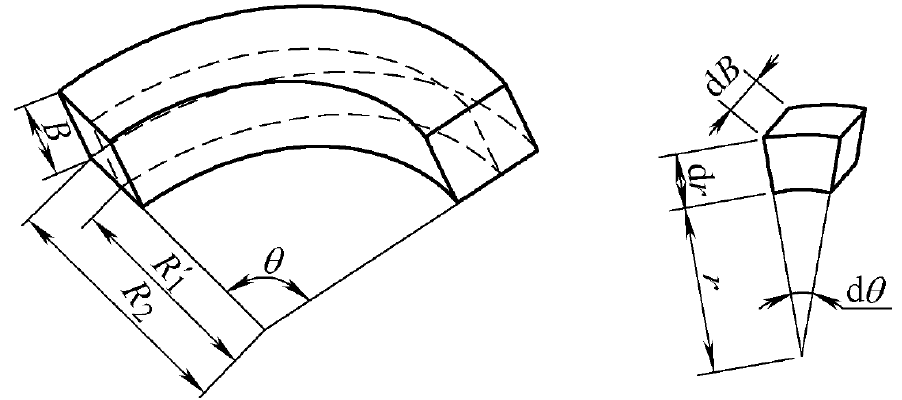
Figure 3. Liquid distribution in the reservoir chamber.